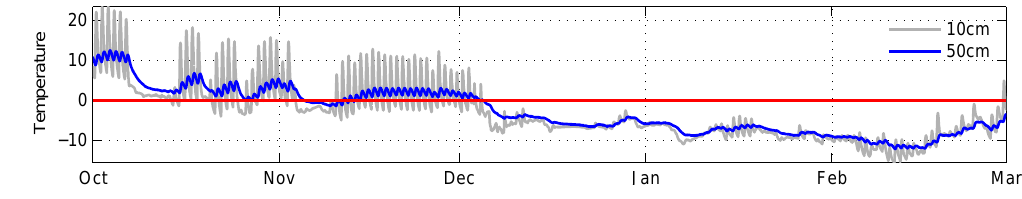
the measurements, we use data measured over short periods, above freezing, during which moisture content is assumed to be